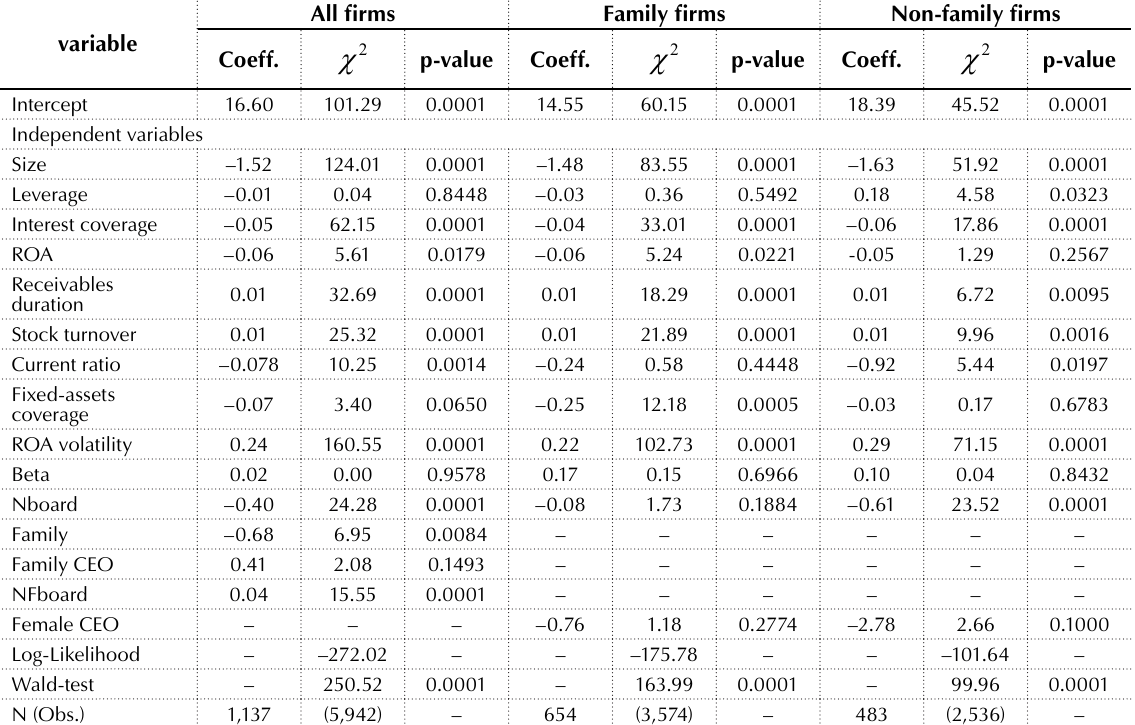
Table 2. Duration independent hazard model with time varying covariates for the period 2004–2013